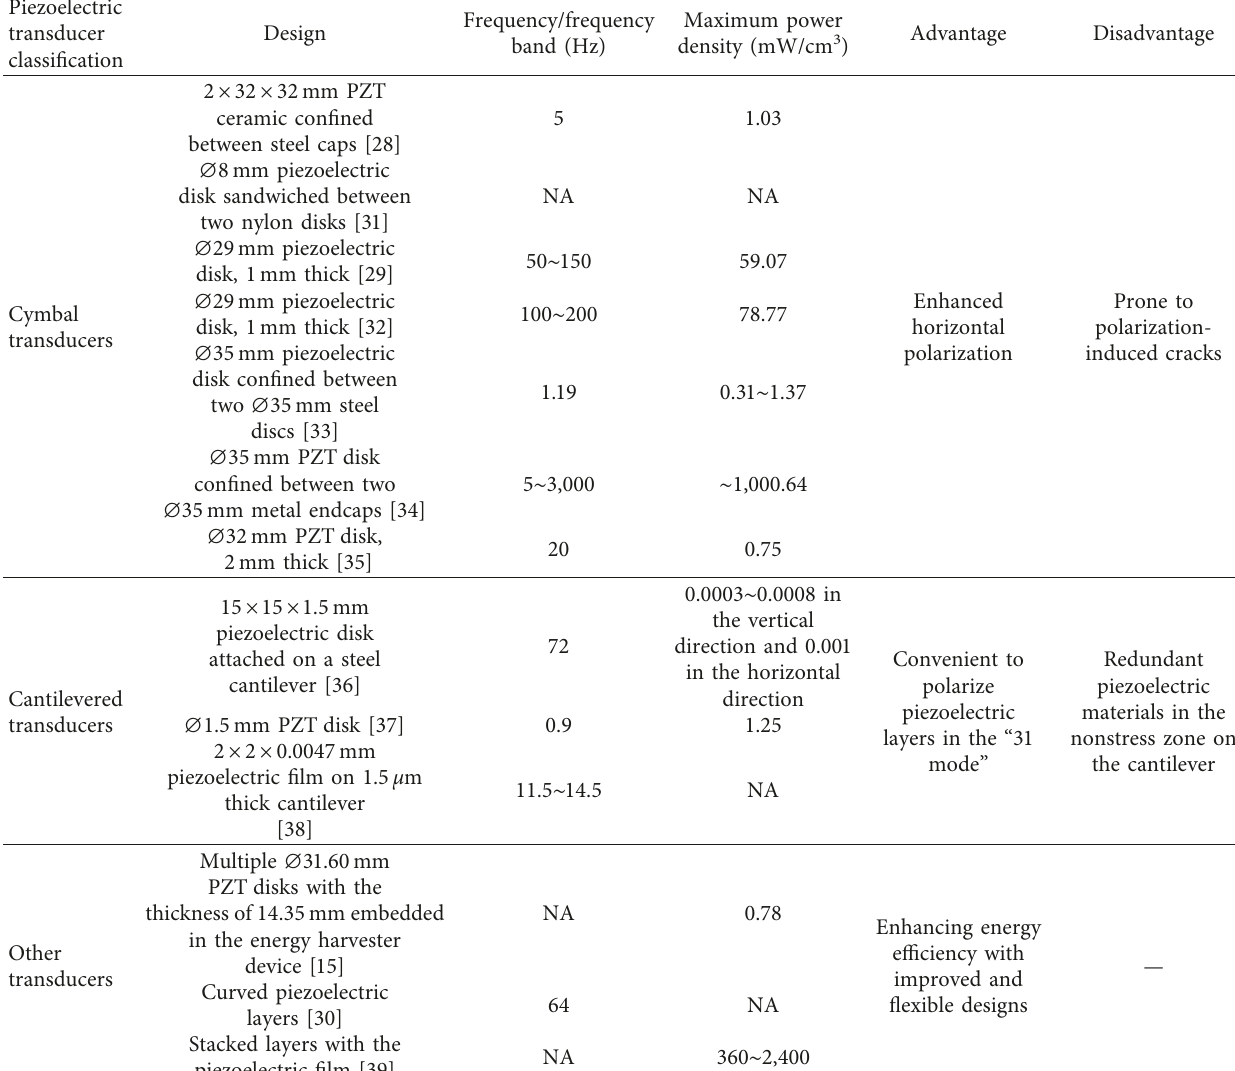
Table 2: Physical design and electric output of piezoelectric